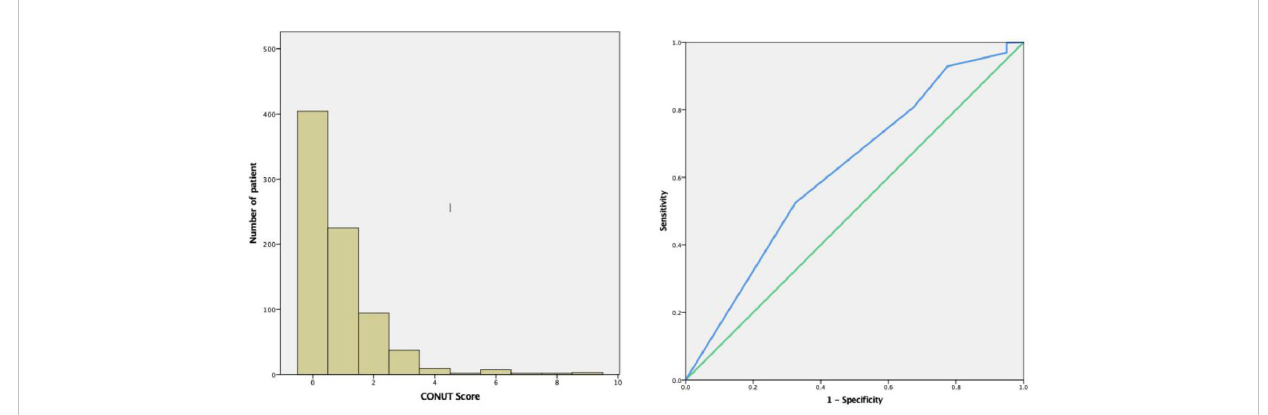
FIGURE 1 Time-related ROC curves showing preoperative CONUT scores for predicting 60 month overall survival (OS) rates. The optimal CONUT cut-off score was 1. (AUC=0.618, 95% con fi dence interval (CI): 0.53 – 0.71, P=0.01. Speci fi city = 67.5% and Sensitivity = 51.7%). ROC, receiver operating characteristic; AUC, area under curve; CONUT, controlling nutritional